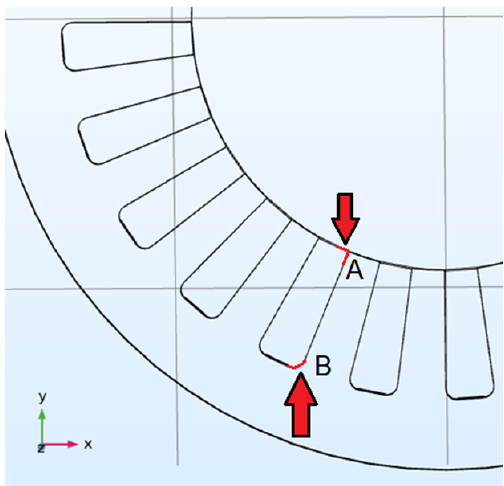
Figure 5. Locations evaluated in the stator machine.